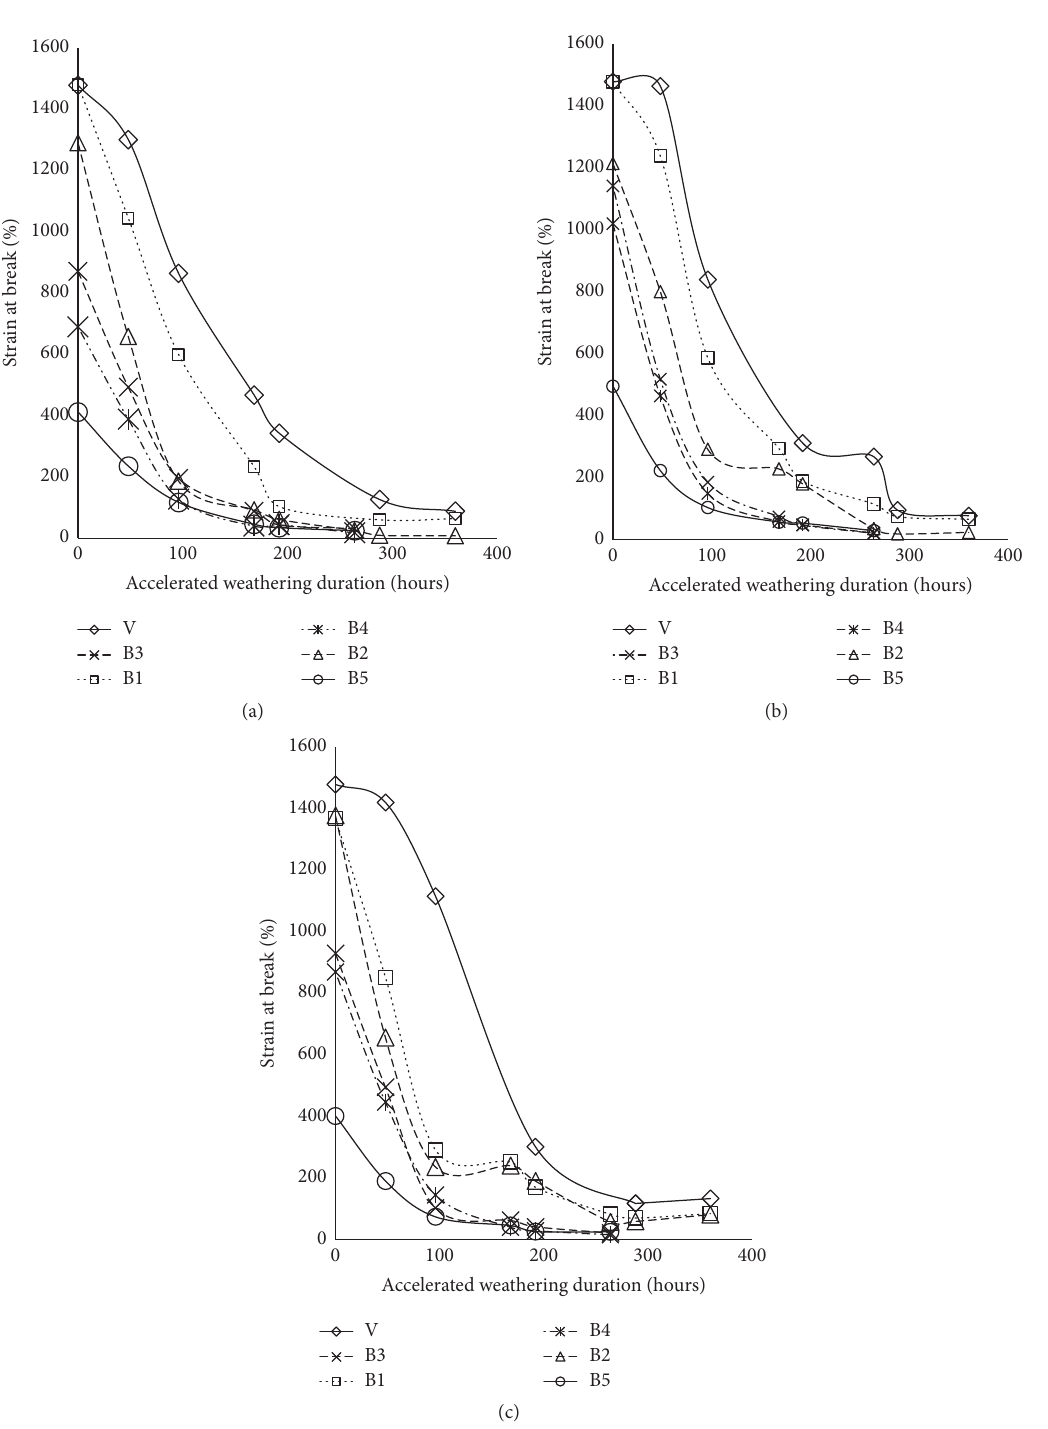
Figure 6: Strain at break (%) of the formulated samples with respect to accelerated weathering duration (days). Samples processed with a Die Head Temperature (DHT) = 175, 185, and 195 ∘ C are shown in (a), (b), and (c), respectively.